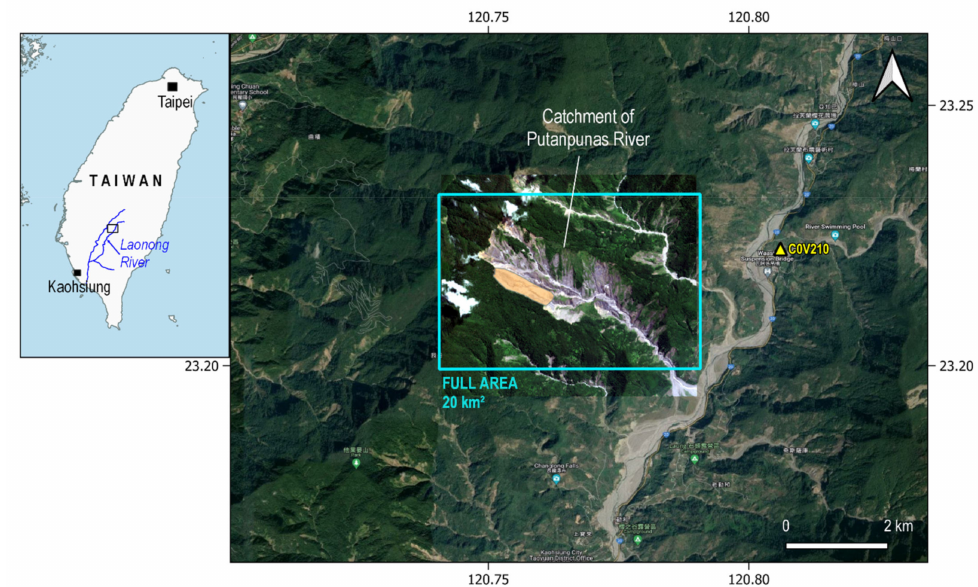
Figure 8. Basemap of the Putanpunas River catchment and the landslide on 7 June 2017. Blue rectangle represents the AOI. Orange polygon: the landslide patch from manual mapping. C0V210 is the weather station. Source of image: SPOT-6/7 acquired on 5 July 2017 overlaid on Google Earth Pro Image © 2022